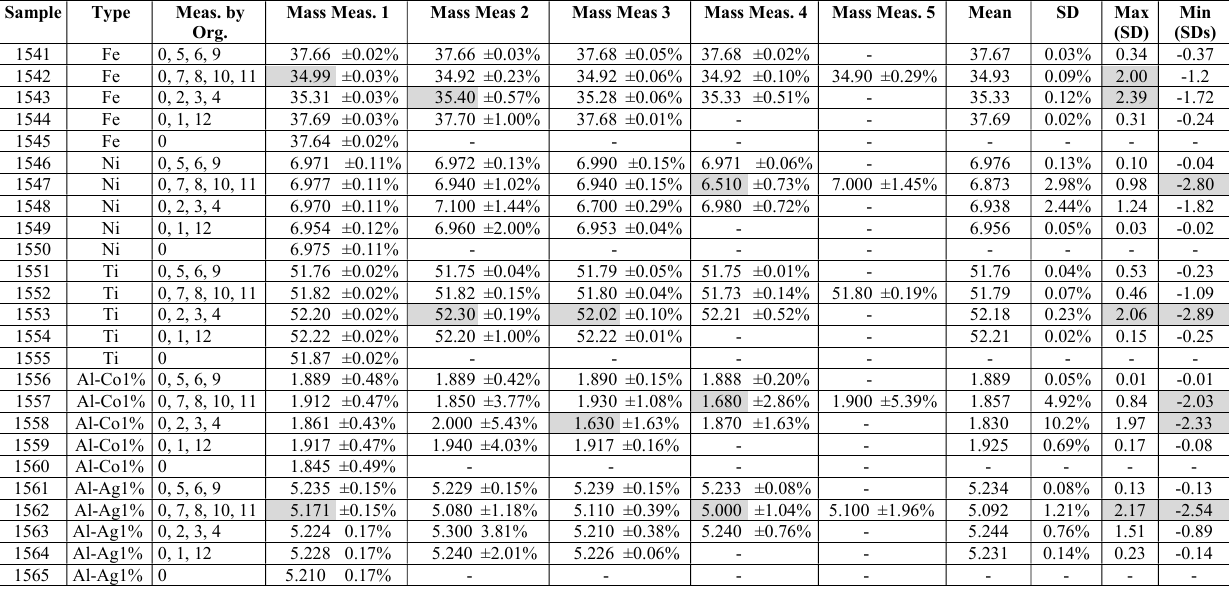
Table 1 Summary of Sample Mass Measurements (see text for explanation of shading) Sample